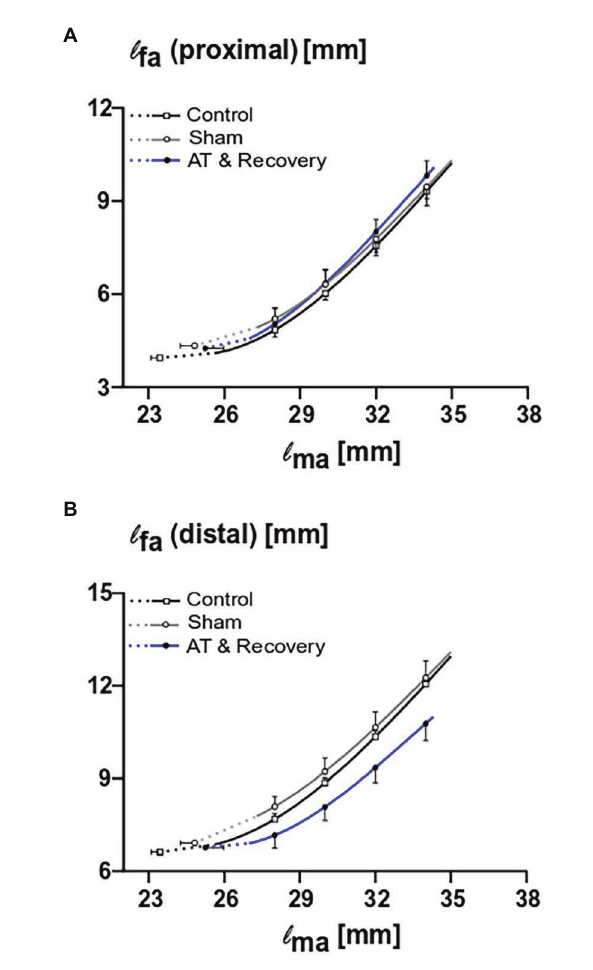
FIGURE 3 | The combined effects of aponeurotomy plus recovery from aponeurotomy on length of muscle fibers. Muscle fiber lengths as function of muscle length are plotted in continuous lines, while extrapolated fiber lengths, ranging from the lowest measured muscle lengths to the estimated muscle active slack length, are plotted as dashed lines. (A) The length of proximal muscle fibers (l fa proximal) as function of active muscle length (l ma ). Proximal muscle fibers from the aponeurotomized and recovered GM show similar lengths as function of muscle length compared to the control muscle fibers ( p = 0.73), indicating that the intervention had no effect on the proximal muscle fibers. (B) The length of distal muscle fibers (l fa distal) as function of active muscle length. Distal muscle fibers from the aponeurotomized and recovered GM show similar lengths as function of muscle length compared to the control muscle fibers ( p = 0.07), indicating that the intervention had no effect on the distal muscle fibers. Two-way mixed ANOVA (with repeated measurements for muscle length) was used to investigate if l fa of the aponeurotomized group was different to that of the control and sham operated. All values are presented as mean and either plus or minus SEM; control n = 10, sham n = 6, AT & recovery n =